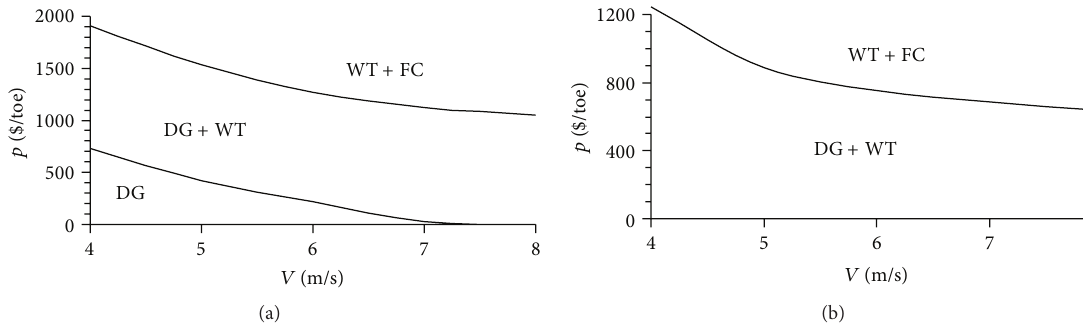
Figure8:Zonesoftechnologicalefficiencywiththeloadpowerof50 kW(a)and1000kW(b)andprospectiveindicesofelectrolyzer,hydrogen tank, and fuel cells for the scheme in Figure 3. 𝑉 is the average wind speed at a height of 10m, 𝑝 is the diesel price, WT are the wind turbines, DG is the diesel generator, and FC are the fuel cells.